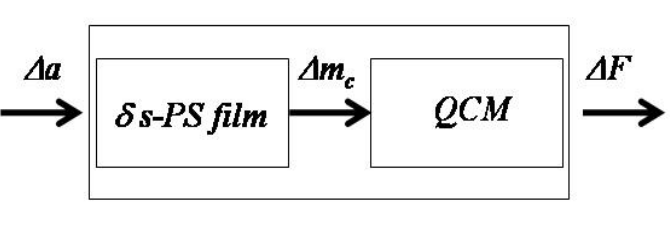
Figure 7. Schematic illustration of the measuring chain for PS coated QCM sensor.